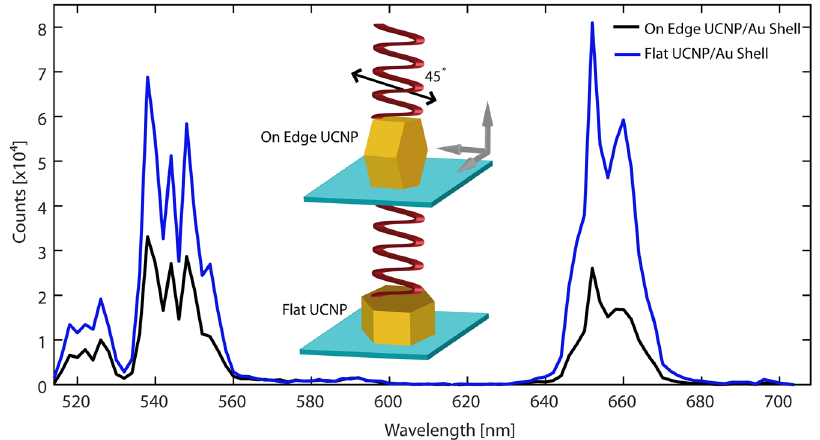
Figure 2. Single particle orientation dependent fluorescence spectra comparing UCNP lying flat (blue) and on edge (black). A 3- to 4-fold difference in intensity is observed at 640–680 nm. The spectral measurement standard deviation is less than